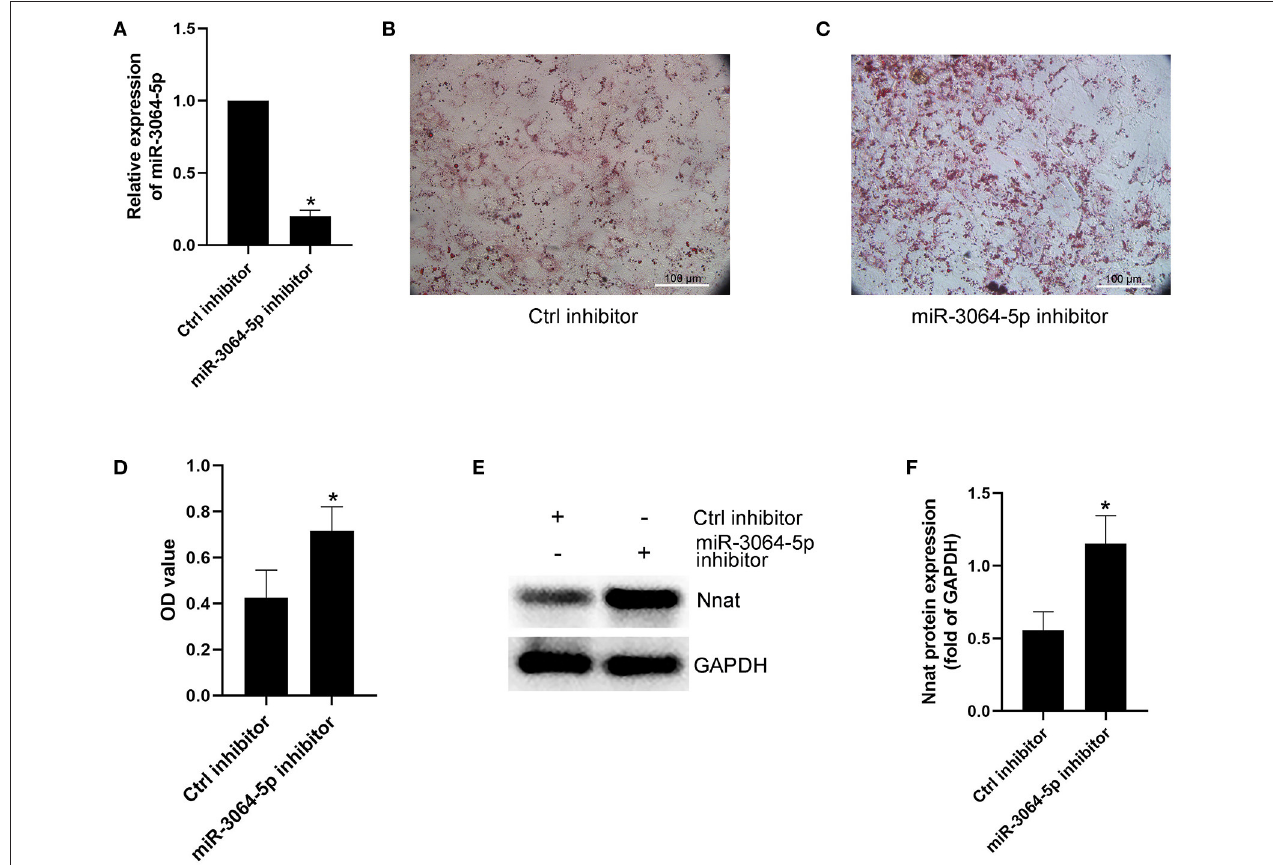
FIGURE 6 | Effect of miR-3064-5p on adipogenic differentiation of EASCs. Here the EASCs were derived from the EAT of CAHD patients. (A) Inhibition of miR-3064-5p after adding exosome-shuttling miR-3064-5p inhibitors to the cell culture medium of EASCs. 24h after incubation, the expression of miR-3064-5p in EASCs was detected using qPCR. (B) The representative image of oil red O staining in Ctrl inhibitor group. (C) The representative image of oil red O staining in miR-3064-5p inhibitor group. (D) Oil red O was extracted and absorbance was determined spectrophotometrically at 450nm to quantify adipogenic differentiation. (E) The protein expression level of Nnat in groups of Ctrl inhibitor and miR-3064-5p inhibitor. (F) Semi quantitative analysis of western blotting in (E) . Data are presented as the means ± standard error of the mean for six independent experiments. * P < 0.05 vs. Ctrl